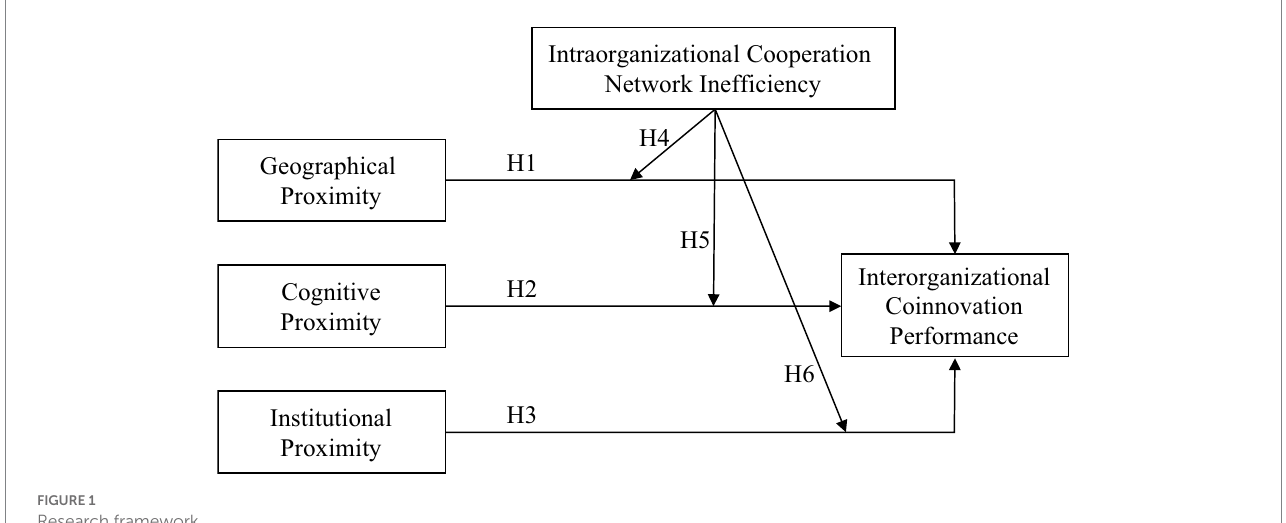
FIGURE 1 Research